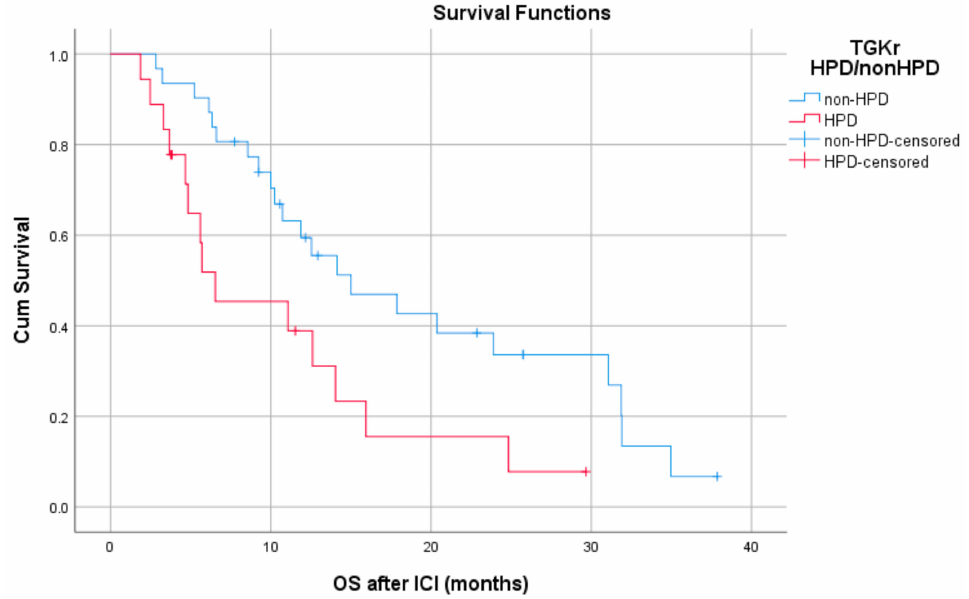
Figure 2. Association of type of progressive disease (HPD vs. non-HPD) with overall survival (OS) following immunotherapy initiation